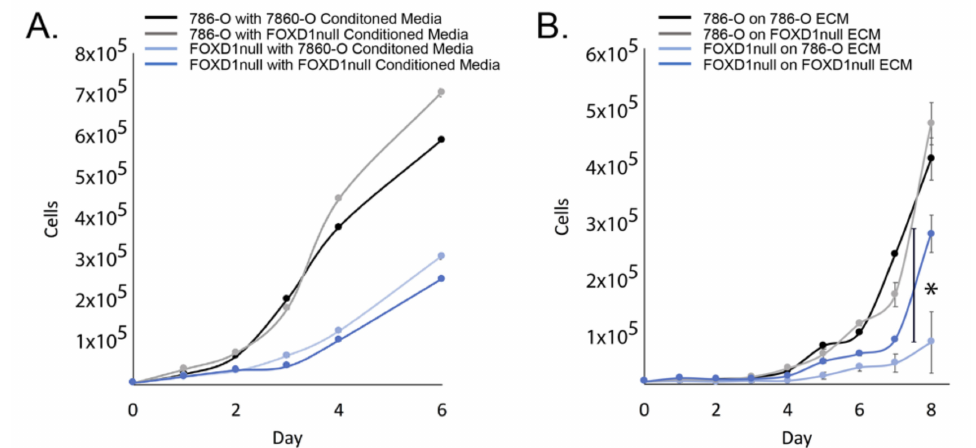
Figure 2. Exclusion of secreted factors and ECM from target discovery. ( A ) growth rate analysis of 786-O and 786-O FOXD1null grown in conditioned media from 786-O or 786-O FOXD1null ; ( B ) growth rate analysis of 786-O and 786-O FOXD1null grown on native decellularized ECM from 786-O or 786- O FOXD1null . * = p -value < 0.05 by Student’s t -test at